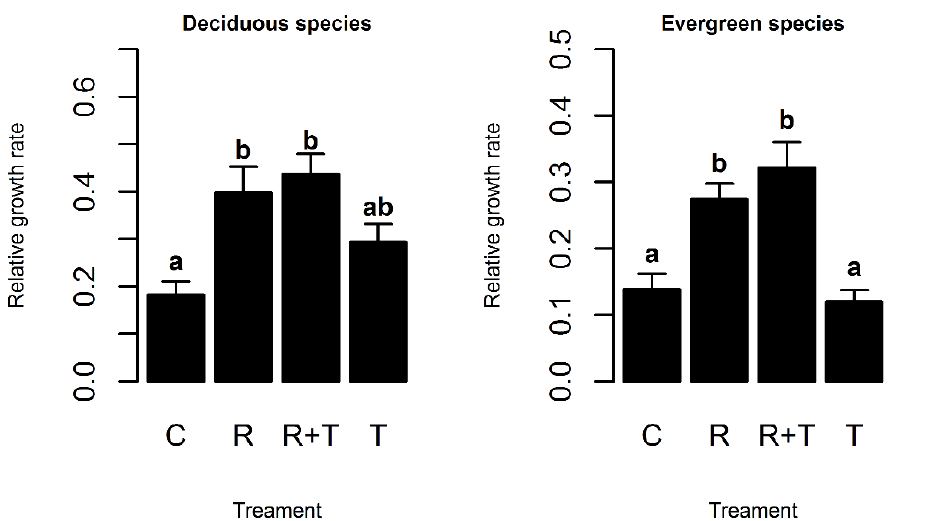
Figure 1. Effects of different treatments on seedling survival rates. Different letters ( a , b ) indicate significant difference ( p ≤ 0.05). significant difference ( p ≤